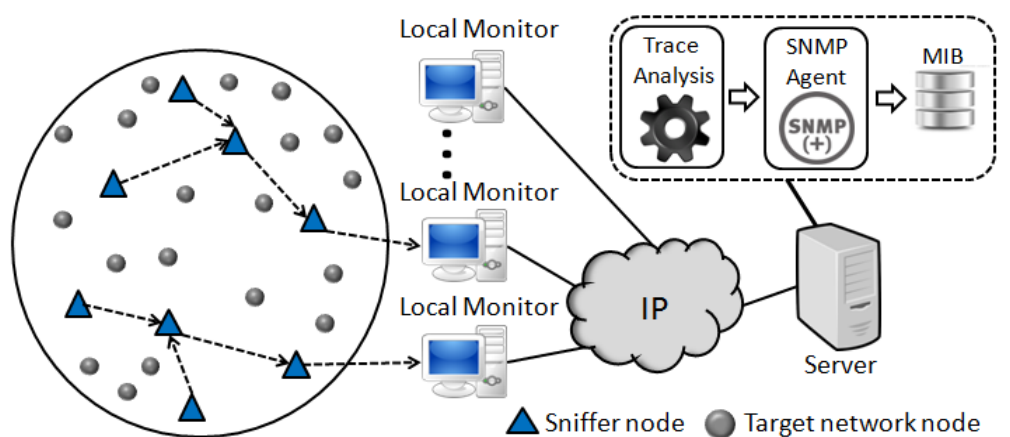
Figure 1. Overview of the EPMOSt.